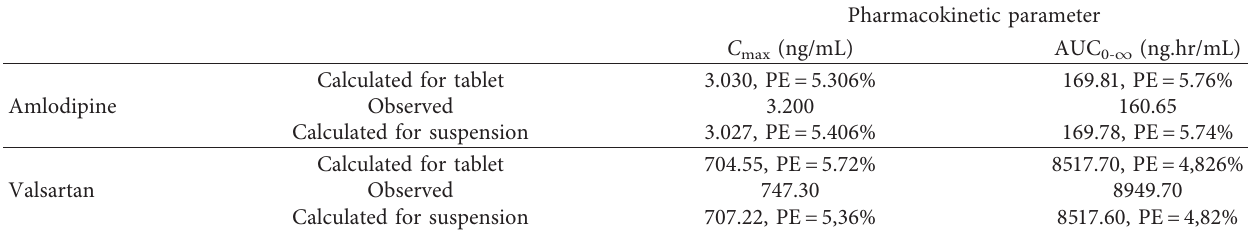
Table 5: Observed and predicted pharmacokinetic parameters with percentage of prediction error for both amlodipine and